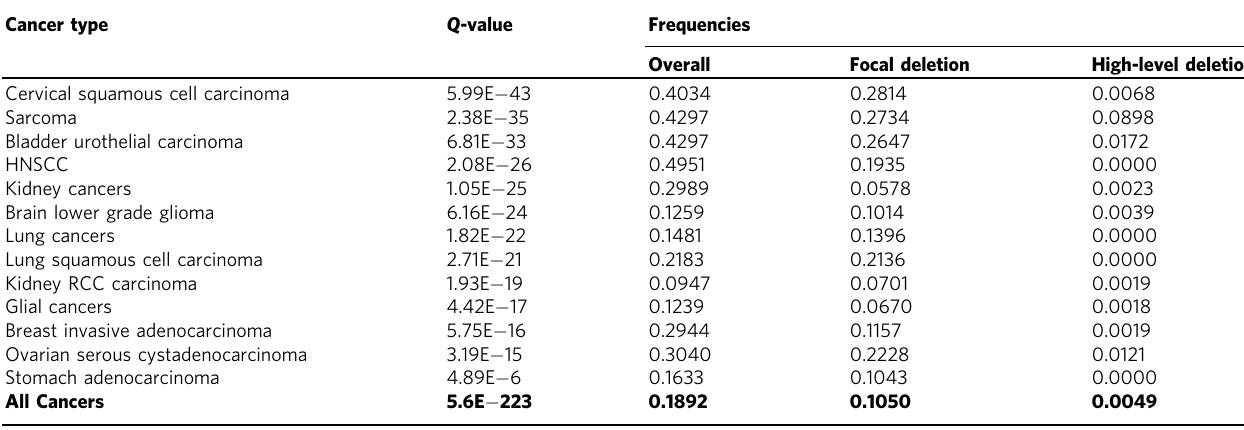
Table 1 Focal deletion of STK25 is common in human cancers Cancer